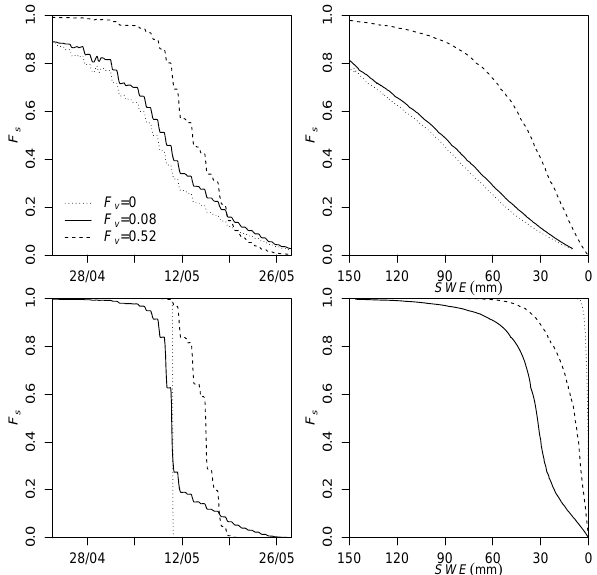
Figure 11. Time series of snow cover fraction (left panels) and snow cover depletion curves (right panels) from simulations with topog- raphy (top panels) or without (bottom panels) for three different area-averaged vegetation